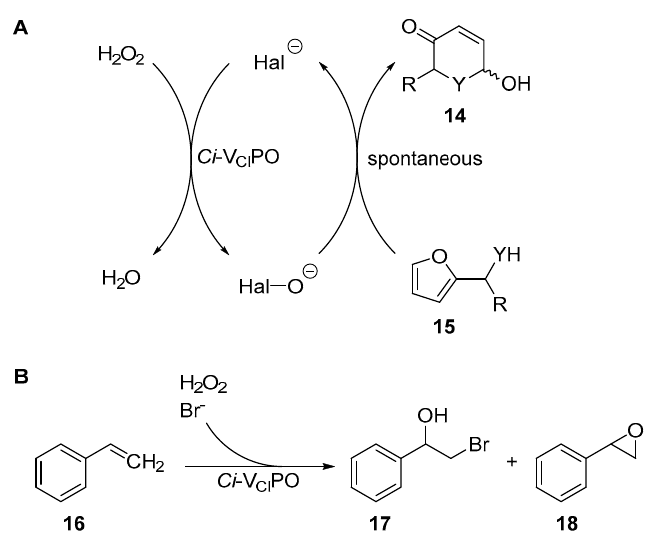
Figure 10. ( A ): (Aza-)Achmatowicz reaction transforming the furan 15 to the Michael-system [78] 14 . ( B ): Halofunctionalization of styrene ( 16 ) [77,79].